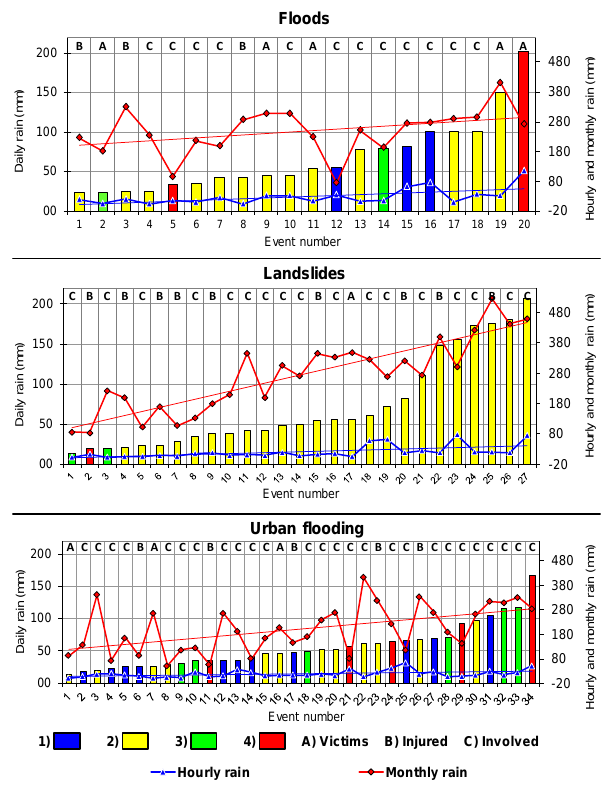
Fig. 5. Each diagram concerns a type of damaging agent. The events, identified by the number on the x-axis, have been sorted according to increasing daily rainfall and the bars representing daily rainfall have been coloured according to the months of occur- rence (blue: August-October; yellow: November-January; green: February-April; red: May-July). On top of each diagram, the types of damage to people recorded in each event have been indicated by letters: occurrence of victims (A), injured (B), and involved peo- ple C). Hourly and monthly rain are also